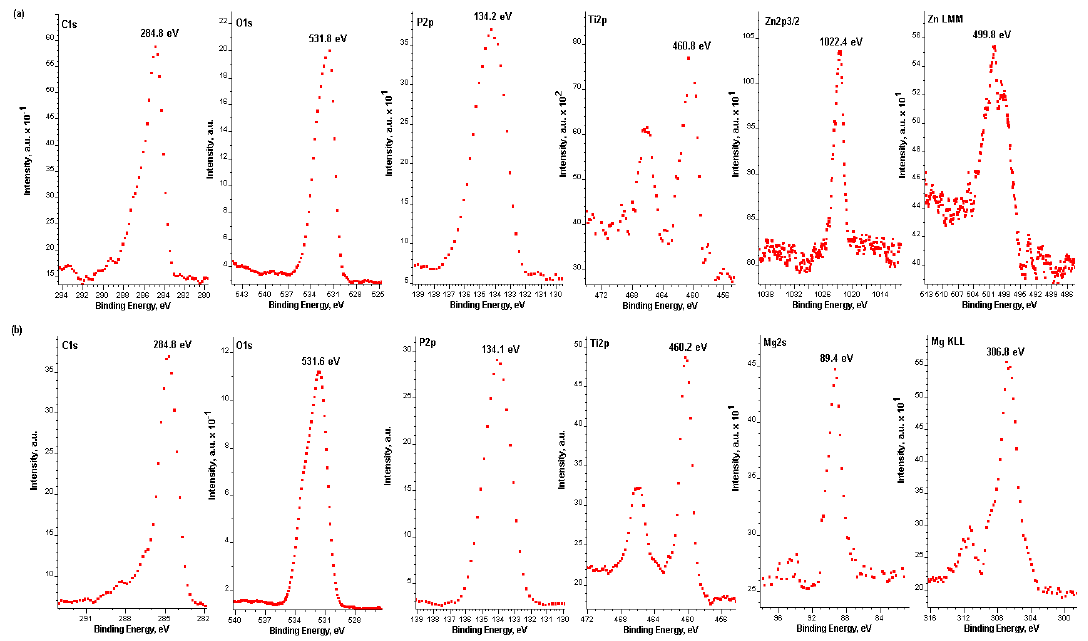
Figure 5. XPS spectra of coatings formed on CP Titanium Grade 2 after PEO treatment at voltage 575 V DC in concentrated H 3 PO 4 electrolytes containing ( a ) 500 g·L − 1 Zn(NO 3 ) 2 ·6H 2 O; and ( b ) 500 g·L − 1 Mg(NO 3 ) 2 ·6H 2